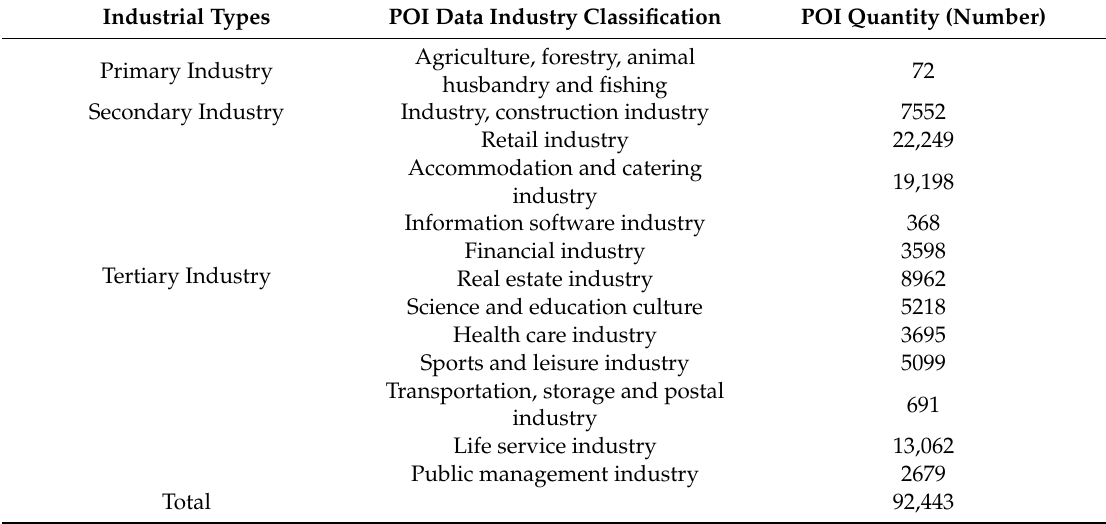
Table 1. The POI (point of interest) data classification